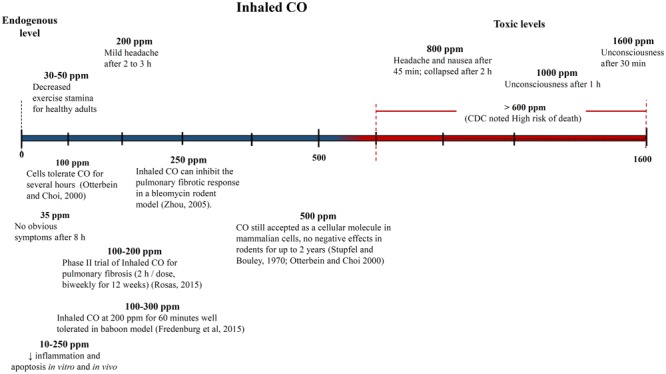
Approximate inhaled CO concentrations (in parts per million) and noted effects. Negative and positive medical effects are shown on the top and bottom, respectively (Stupfel and Bouley, 1970; Zhou et al., 2005; Rosas, 2015). The effects without corresponding citations are from a CDC publication (Wilbur et al., 2012).